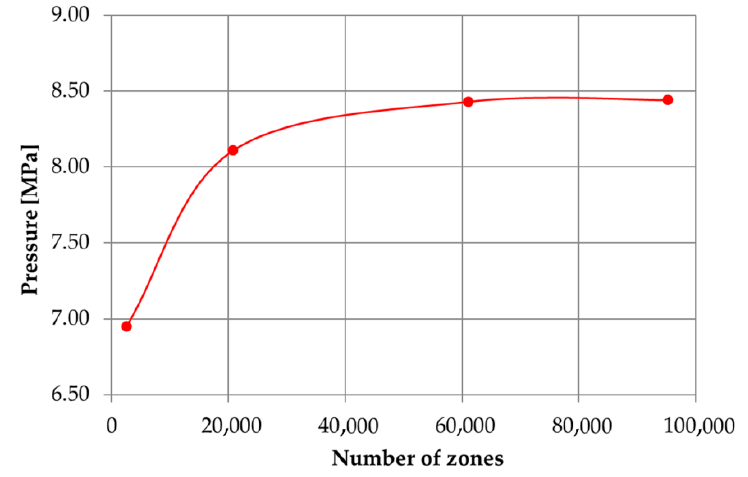
Figure 7. Convergence of results in the numerical grid density study. The results of the four numerical grid densities were compared in Table